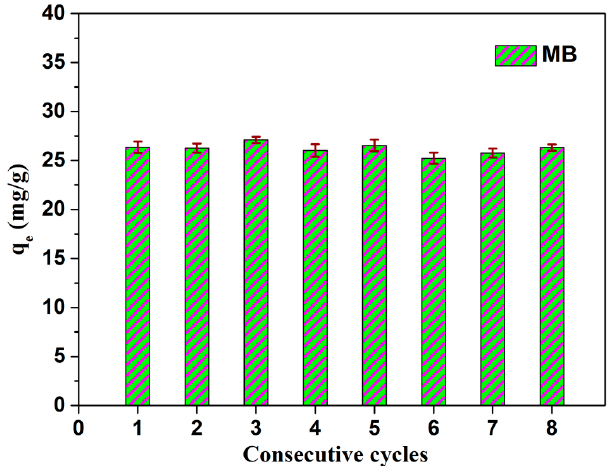
Figure 8. Relative photocatalytic capacity and regeneration studies of as-prepared PVA/PAA/GO- COOH@AgNPs nanocomposite towards MB at room temperature for different consecutive